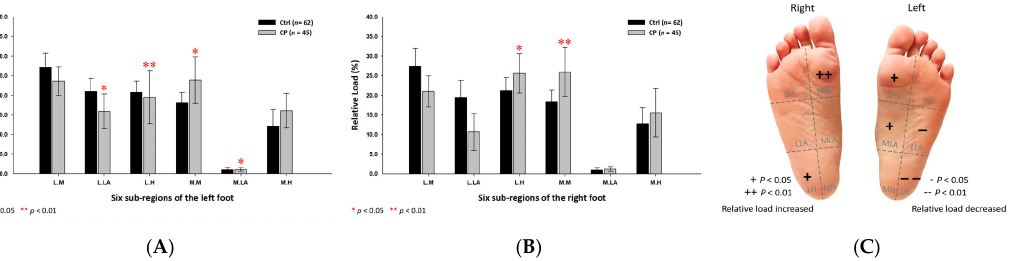
Figure 2. The percentage of six subregional relative loads of ( A ) left and ( B ) right feet in total students during static stance. The changes in pressure distribution are illustrated in ( C ) foot plantar diagram. Significant differences between the control group and the CP group were determined as * p < 0.05 and ** p < 0.01. Six subregions of the foot and the abbreviations are as follows: LM lateral metatarsal bone; LLA, lateral longitudinal arch; LH, lateral heel; MM, medial metatarsal bone; MLA, medial longitudinal arch and MH, medial heel. In addition, the male CP group’s six subregional relative loads were primarily dis- tributed at the medial metatarsals (left foot: 22.54% ± 7.40%; right foot: 27.57% ± 8.28%; p < 0.05) and the lateral heels (left foot: 23.86% ± 4.21%; right foot: 28.05% ± 5.10%; p < 0.05) of both feet, and the medial heel (17.58% ± 7.70%; p < 0.05) of the right foot (Figure 3).